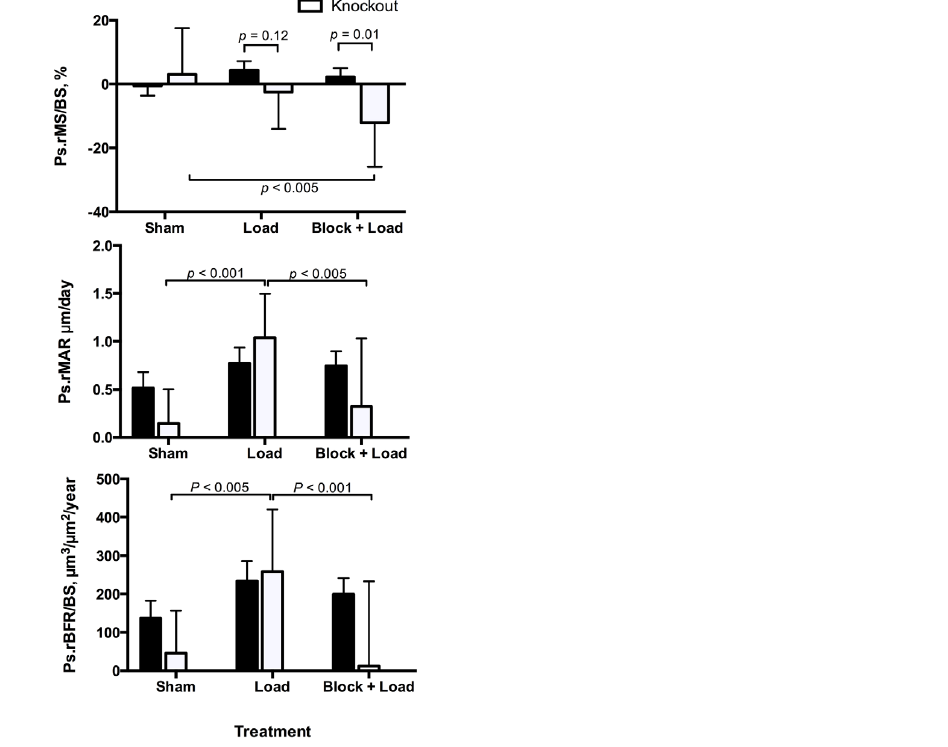
Fig. 4. Adaptive periosteal bone responses in CGRP a wildtype and knockout mice are mainly influenced by changes in mineral apposition rate. Cyclic loading of the right ulna in CGRP a knockout mice, but not wild-type mice, induced significant changes in relative periosteal mineral apposition rate (Ps.rMAR). Blocking of periosteal relative mineral apposition rate (Ps.rMAR) and periosteal relative bone formation rate (Ps.rBFR/BS) by brachial plexus anesthesia (BPA) was also found in CGRP a knockout mice, but not wildtype mice. Sham – sham loaded group, Load – loaded group, Block + Load – BPA treatment before loading. n 5 11–14 mice/group.